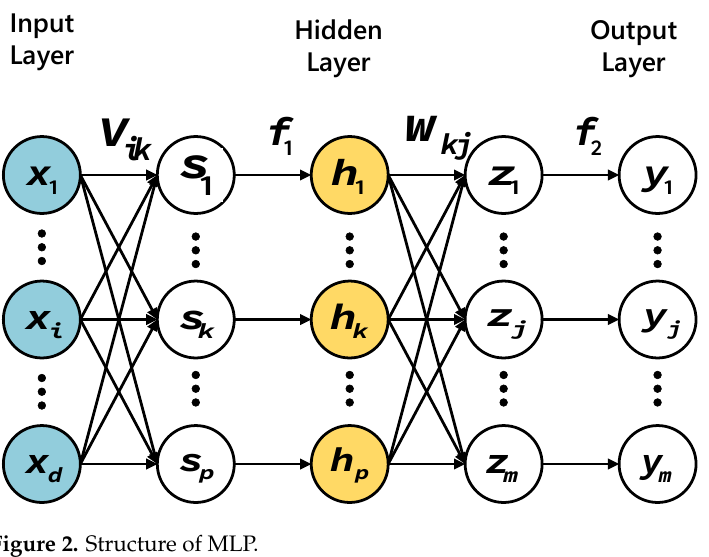
Figure 2. Structure of MLP.